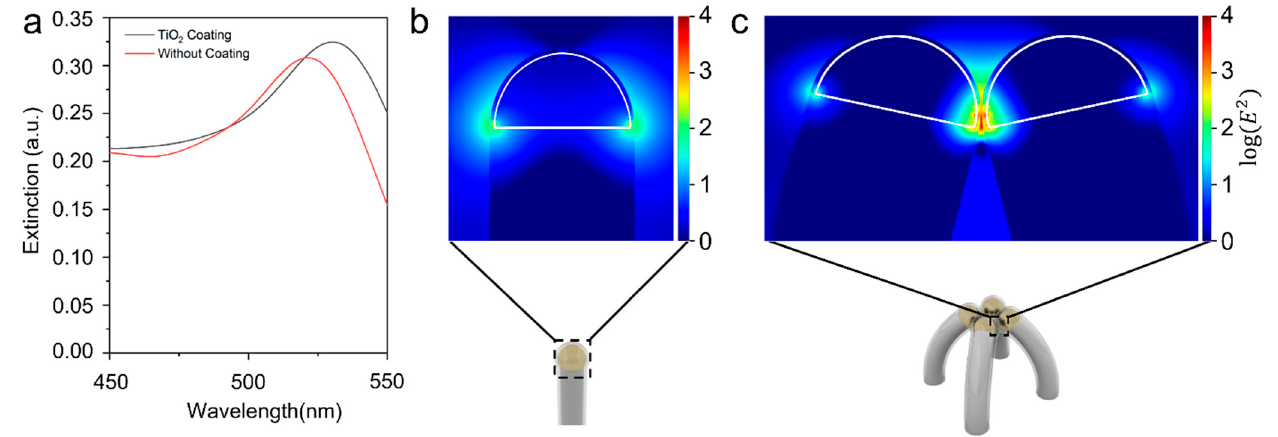
Figure 3. ( a ) Extinction spectra of nanofingers without and with 2 nm TiO 2 coating. ( b ) Simulated electric field distribution for uncollapsed nanofingers. ( c ) Simulated electric field distribution for collapsed nanofingers.